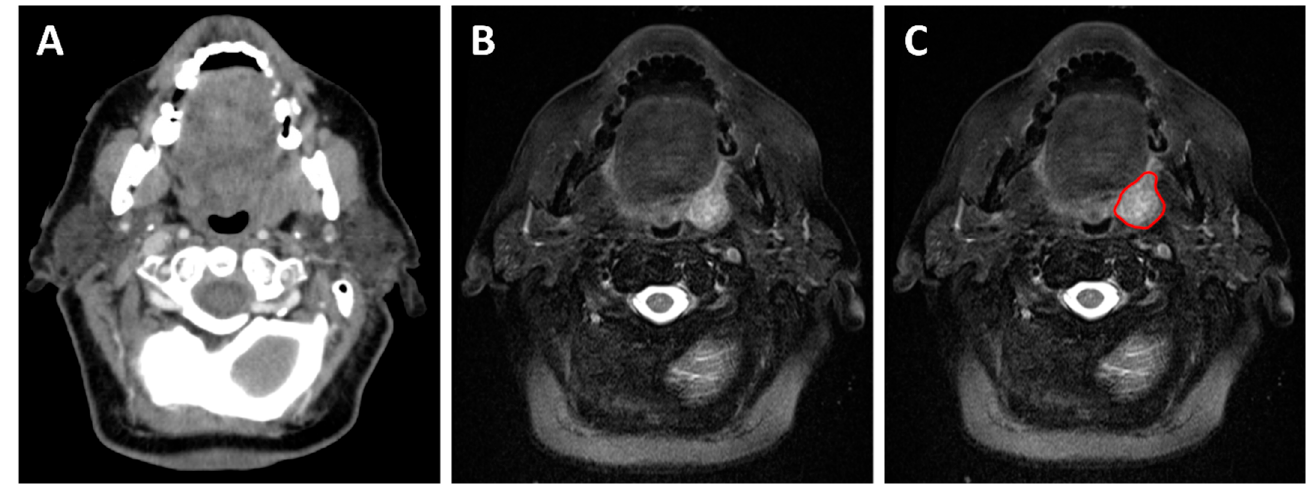
Figure 4. A 73-year-old patient with a cT2N1 p16-positive squamous cell carcinoma of the left tonsil planned for concurrent chemoradiotherapy. The planning contrast-enhanced CT ( A ) shows an asymmetrical left tonsil with poorly defined margins. The planning T2-weighted MRI ( B , C ) allows better visualization of the tumor margin and aids in the delineation of the gross tumor volume during radiation treatment planning (red contour).